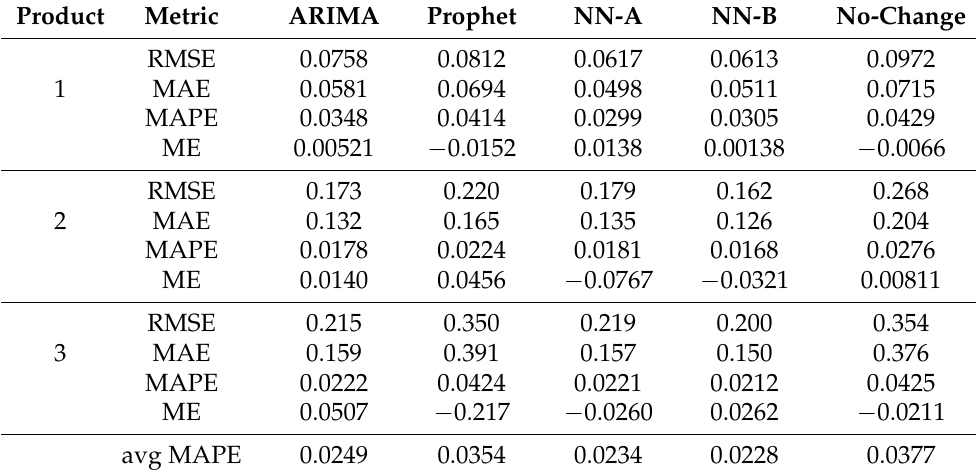
Table 10. Comparison of model performances on the test dataset. NN-A and NN-B indicate class A and class B neural network models, respectively, while no-change denotes the model where the price is forecasted to be equal to the latest value of the